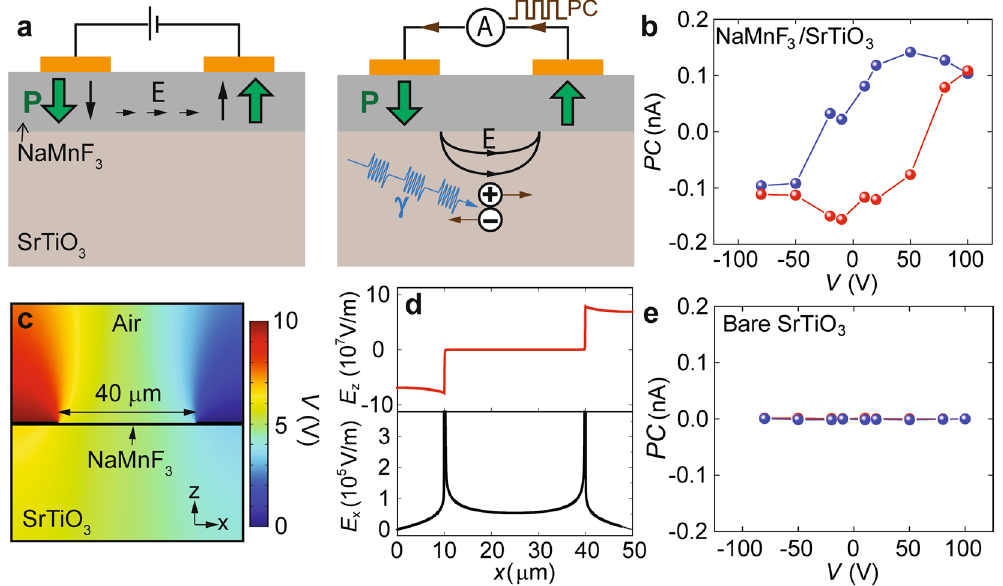
Figure 7. Photocurrent generated from the persistent polarizations in NaMnF 3 . ( a ) Illustration of DC bias poling and subsequent AC photocurrent measurements. ( b ) Hysteresis of AC photocurrent measured at 5 K after the application of different DC biases. Different colors indicate the data taken during increasing (red) or decreasing (blue) bias sequences. ( c ) Simulated potential distribution in the heterostructure at 10 V DC bias. ( d ) Simulated out-of-plane and in-plane field distributions in NaMnF 3 film at 10 V DC bias. ( e ) Control experiment performed on bare SrTiO 3 substrate under identical conditions, where no photocurrent was